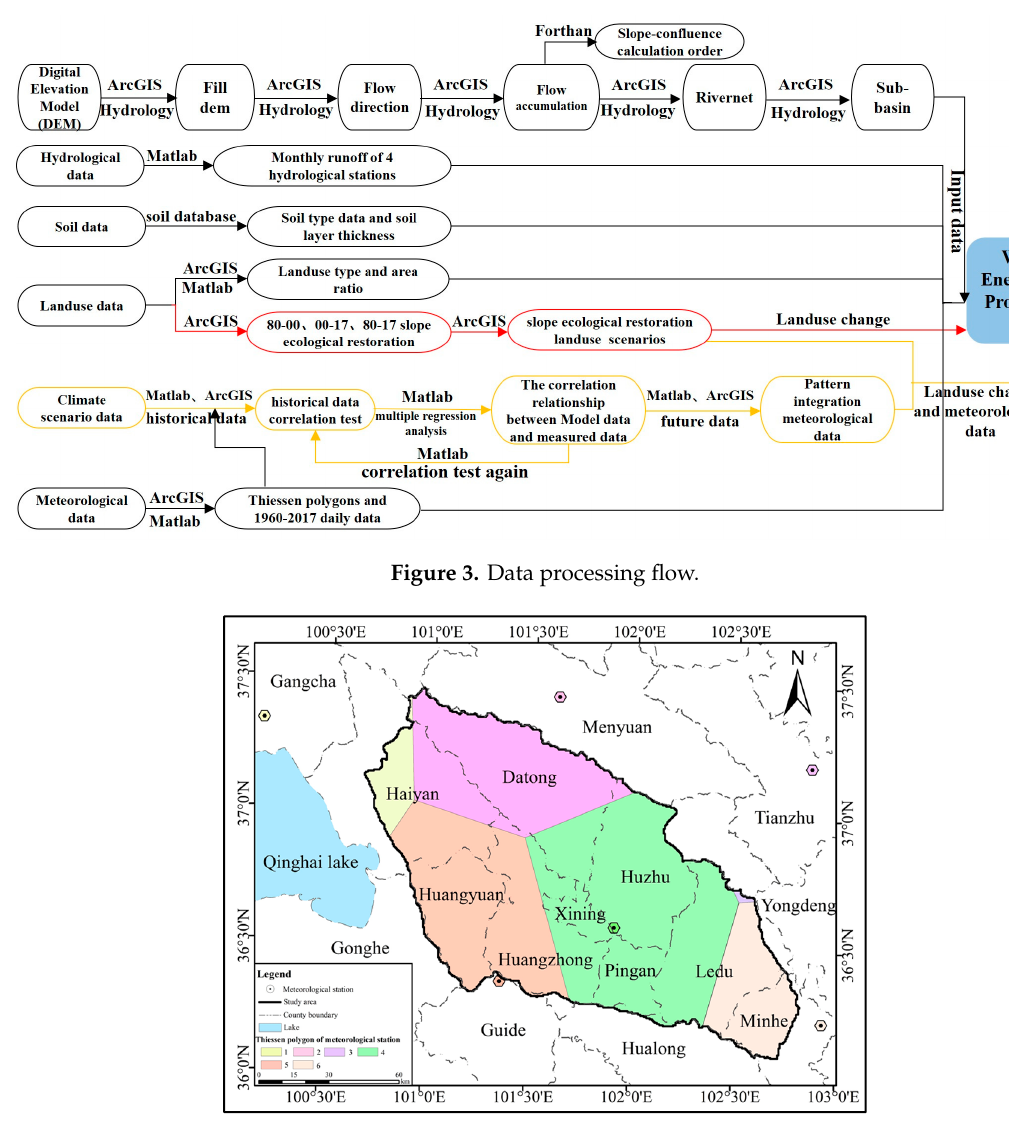
Figure 4. Meteorological stations and Thiessen polygons.